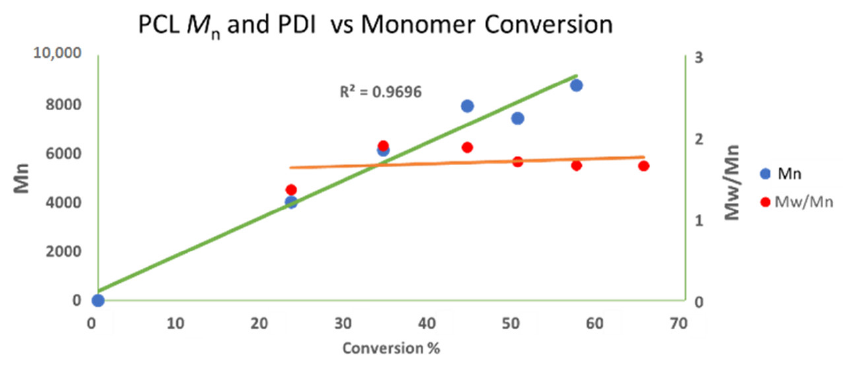
Table 3. Polymerization results for the ROP of ε -caprolactone mediated by complex 4 .